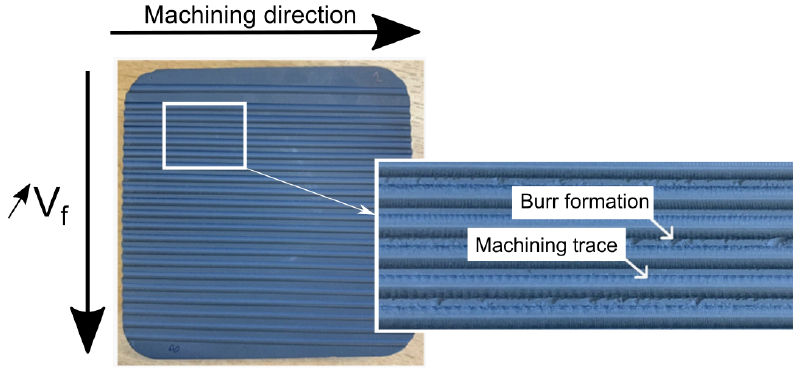
Figure 3 . Visual observation of machining quality . Figure 3. Visual observation of machining quality.